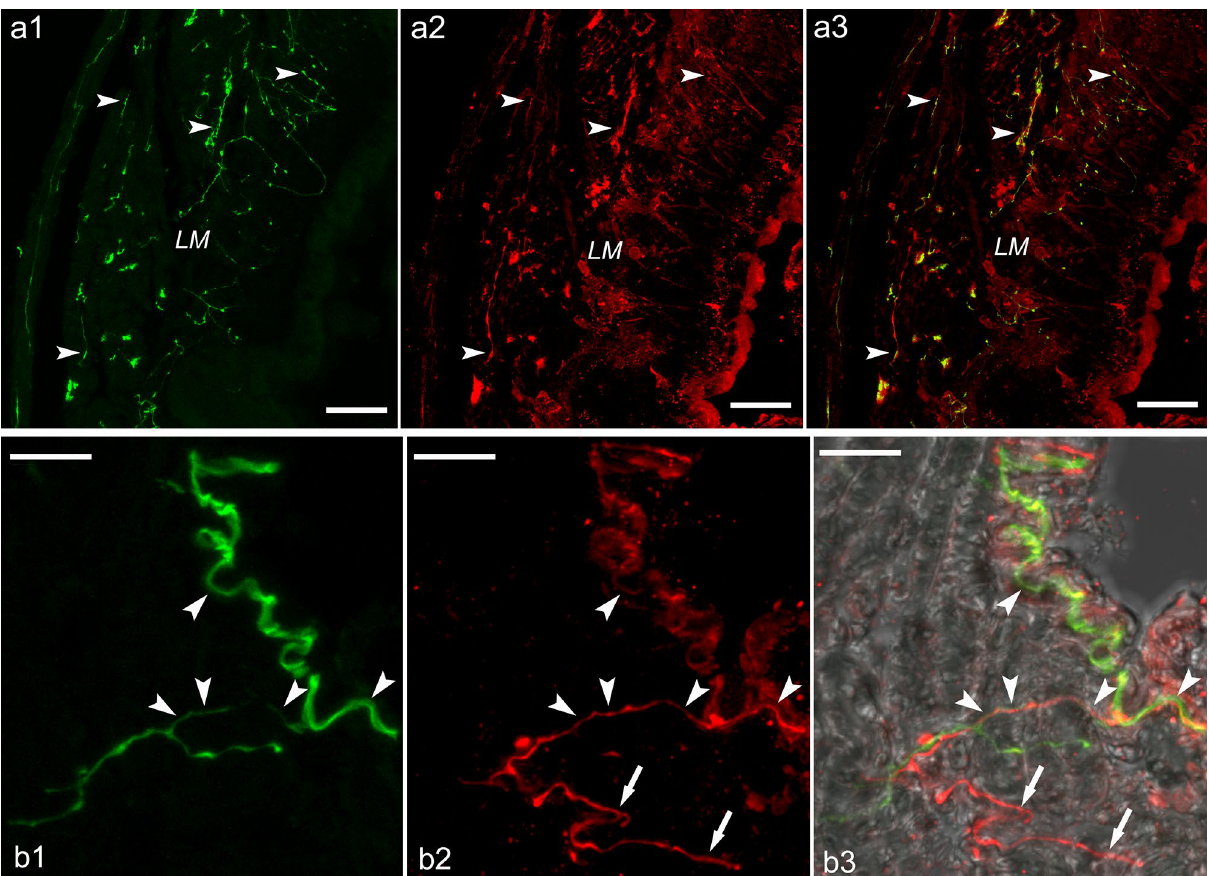
Figure 5. Representative 5-HT (green) and ly-GnRH/CRZ (red) IHC of the preputium ( a1 – a3 ) and the heart atria ( b1 – b3 ). Axon fiber bundles containing both 5-HT and ly-GnRH/CRZ (arrowheads) can be seen on the longitudinal muscle of the preputium. On the surface of the heart atria muscle, axon fiber bundles containing only ly-GnRH/CRZ (arrows) or both 5-HT and ly-GnRH/CRZ (arrowheads) are present. Scale bars = 40 µm ( a1 – a3 ) and 10 µm ( b1 – b3 ). LM longitudinal